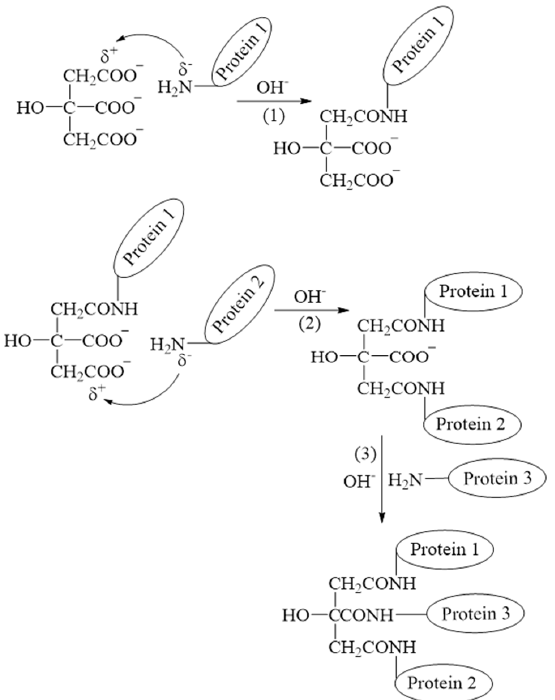
Figure 2. Scheme showing the first reaction (1) where nucleophilic substitution occurs between carboxyl groups in citric acid and the nucleophilic amine groups in one protein (protein 1); (2) second reaction showing more than one carboxyl groups of citric acid reacting with two proteins (protein 1 and 2) which could result in either intra/inter-crosslinking; reaction (3) showing all the three carboxyl groups of citric acid involved in crosslinking three proteins (proteins 1, 2 and 3). Nucleophilic substi- tution occurs by the attack of a partial negative charge on the nitrogen of NH 2 on the partial positive charge on COO − , resulting in amide bond formation only in increased pH